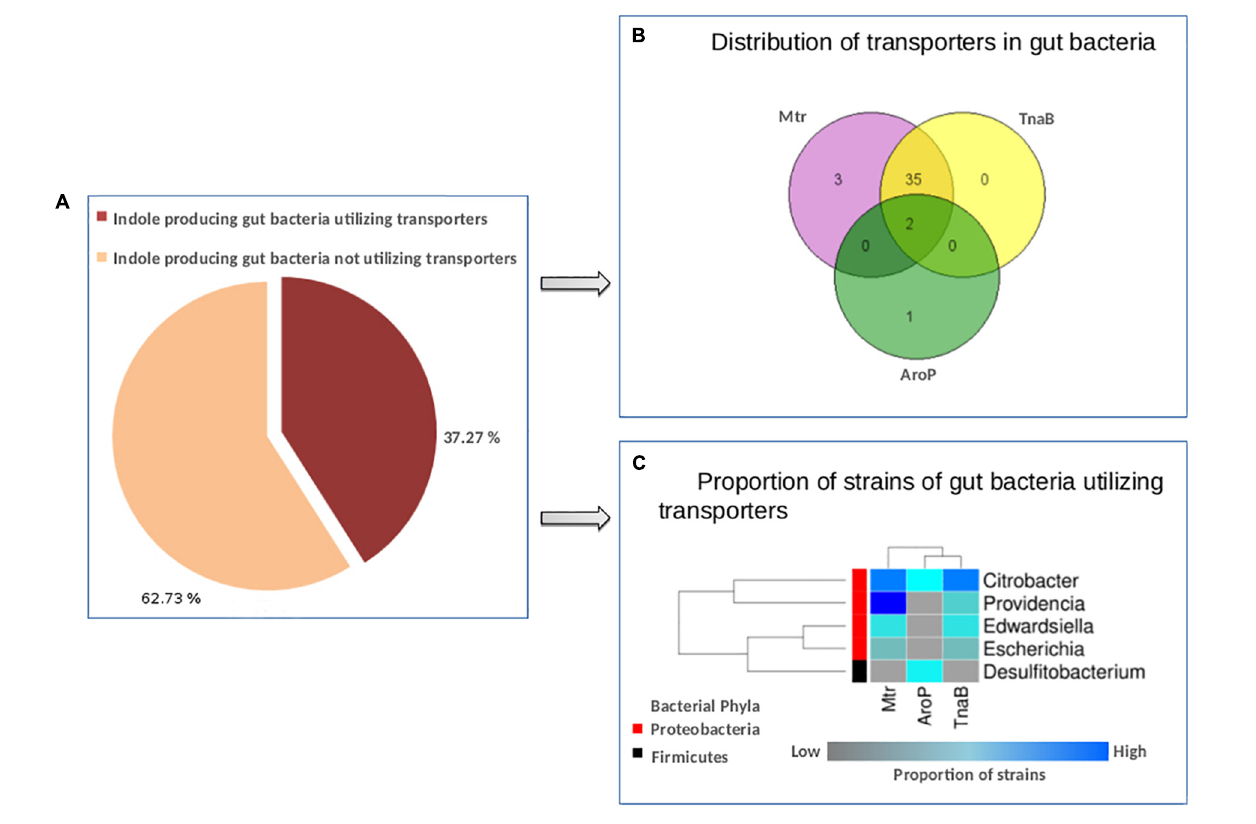
FIGURE 5 | Distribution of tryptophan transporters in gut bacteria. (A) Pie-chart depicting the proportion of indole producing gut bacteria predicted to have tryptophan transporters versus those not utilizing the same. (B) Venn diagram representing the distribution profile of three known transporters namely, TnaB, Mtr, and AroP in gut bacteria. (C) Heat-map showing the proportion of strains in each of the five gut bacterial genera predicted to utilize the three tryptophan transporters (TnaB, Mtr, and AroP).